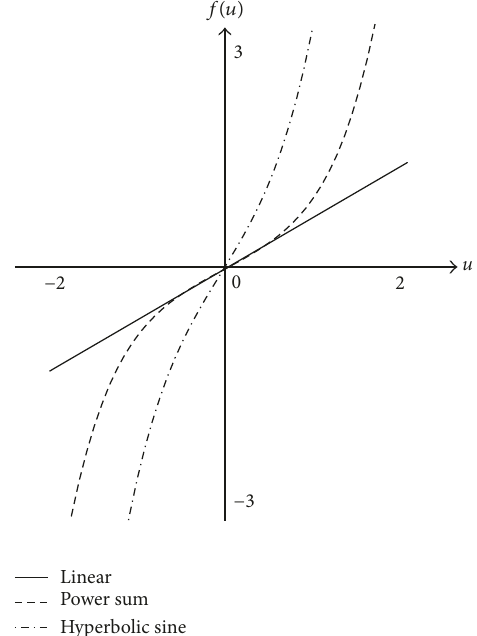
Figure 1: The general recurrent neural network model (2) utilizes the three types of activation functions: linear, power sum ( 𝑁 = 3 ), and hyperbolic sine ( 𝜉 = 3